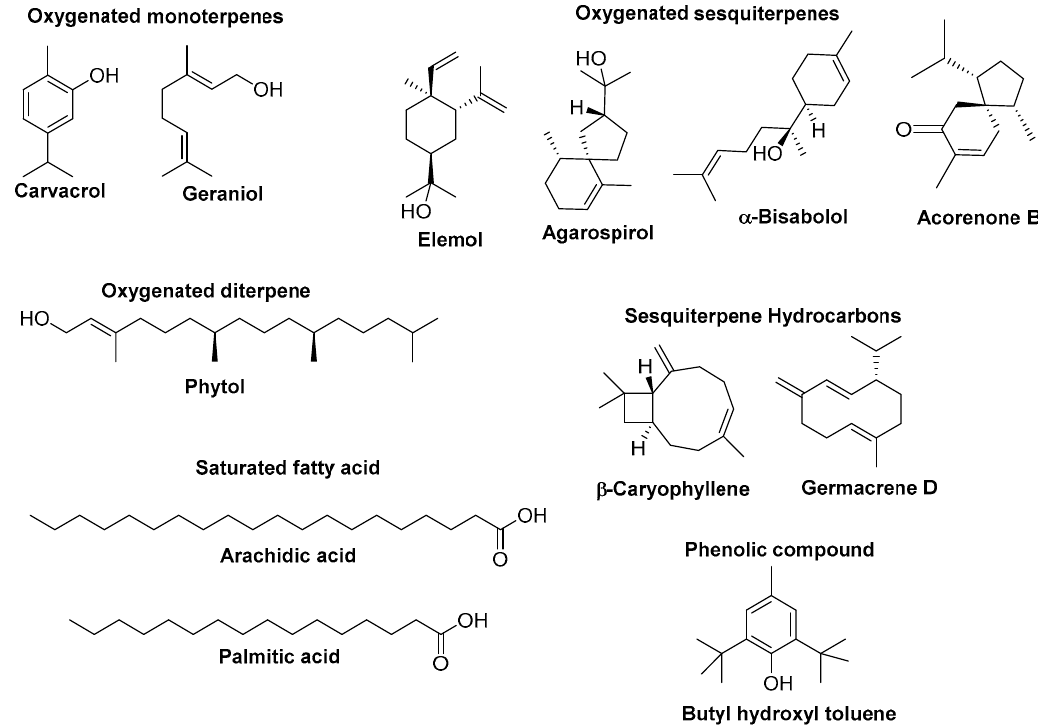
Figure 1. Chemical structures of the constituents of Euphorbia essential oil, each one with a content exceeding 25%.